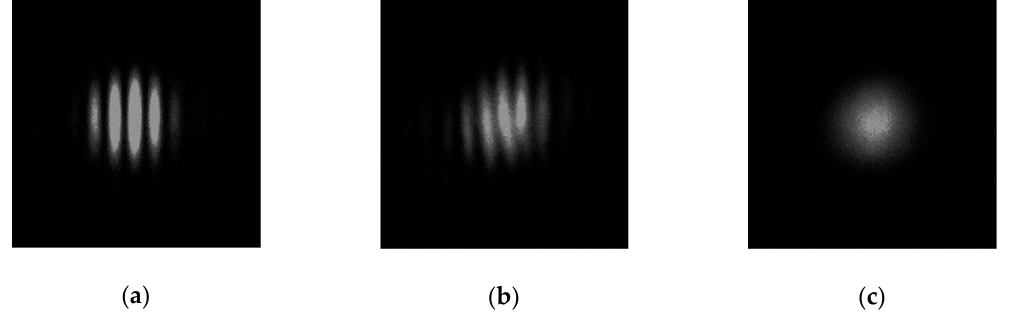
Figure 5. The fringe pattern photos captured by the CCD camera placed in the Fourier plane. The VAN cell was inserted in the interferometer’s probe arm. Linear horizontal polarization of the incident beam was used and the reference beam was linearly polarized. By applying different voltages to the cell, the DOP of the probe beam was: ( a ) 100%, ( b ) 50%, and ( c ) 2%. The main goal of this paper was to measure the phase shift caused by the VAN cell switching.